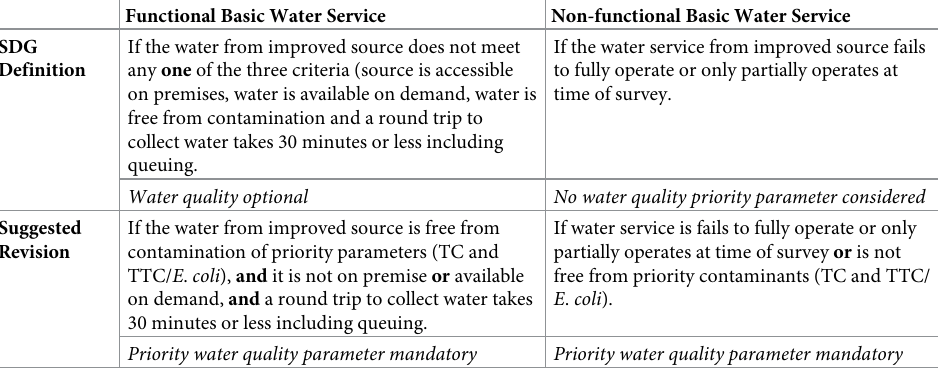
Table 11. Suggested revisions to basic water services—Adding water quality parameters to functional and non- functional